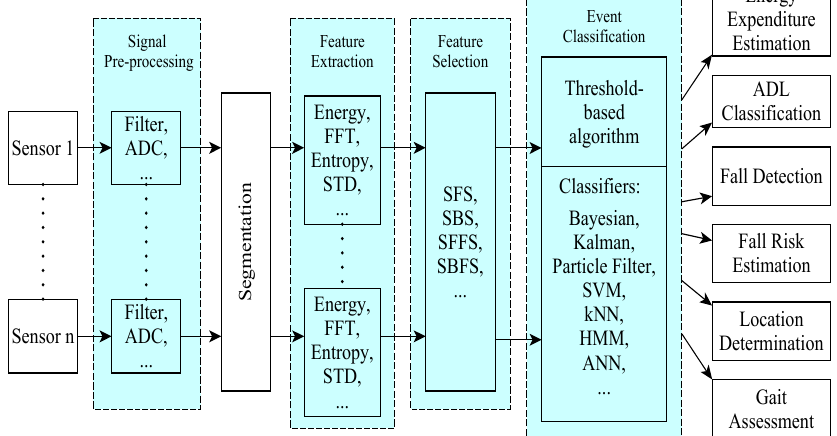
Figure 5. Sensor data processing and analysis (based on